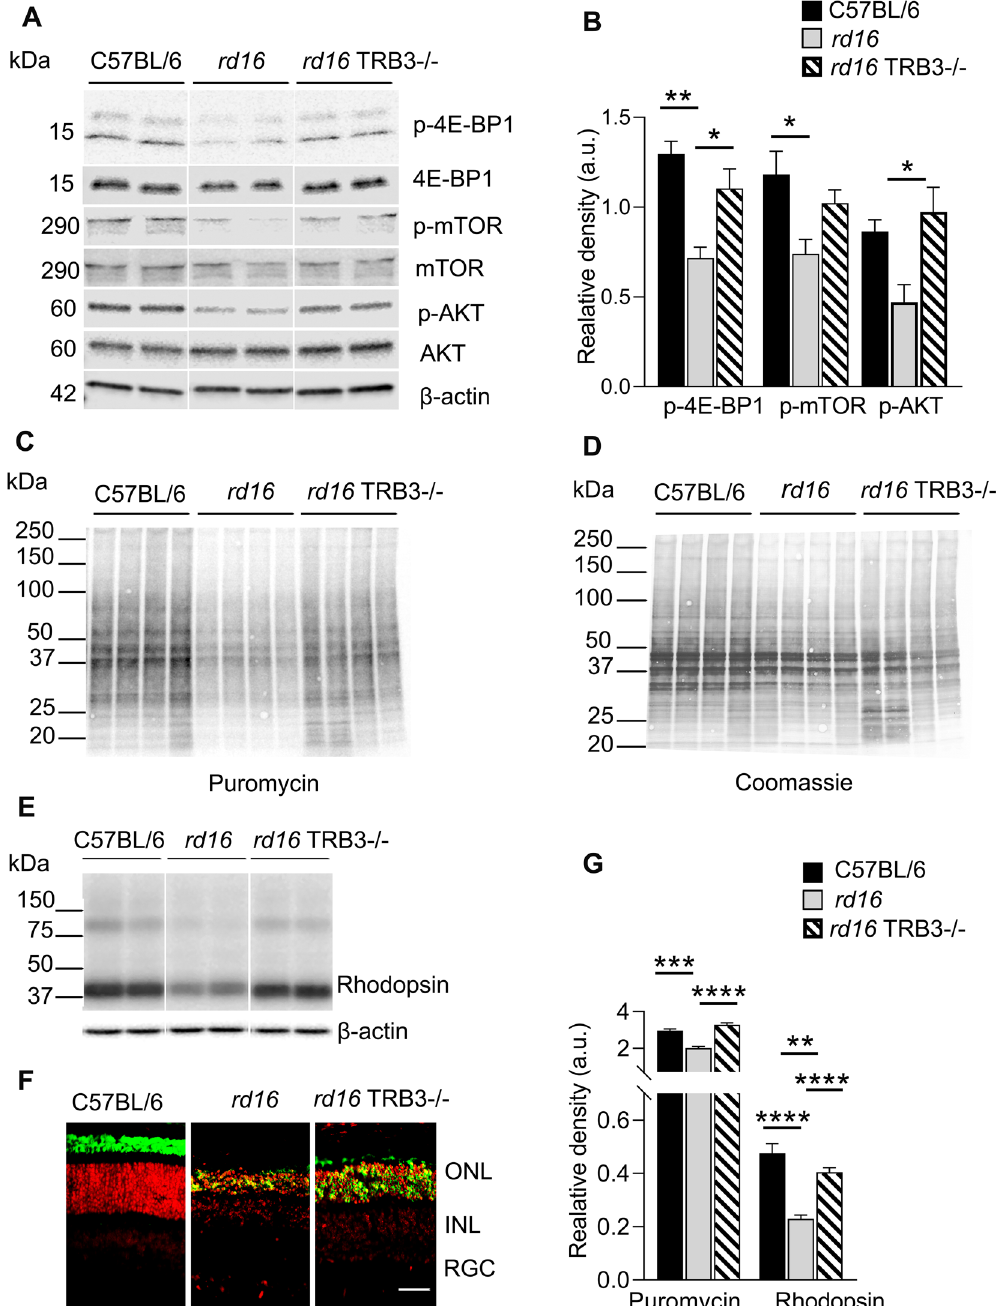
Fig. 1 TRB3 ablation restores the p-AKT/p-mTOR axis in rd16 retinas. A Images of western blot membranes treated with anti-p-4E-BP1, -4E- BP1, -p-mTOR, -mTOR, p-AKT Ser473 , -AKT, and -actin primary antibodies and secondary antibodies scanned with LI-COR imager in three groups of mice. B Quantitation of band density of western blot images demonstrates a statistically signi fi cant increase in p-4E-BP1 and p-AKT in rd16 TRB3 − / − retinas. Increase in p-4E-BP1 was also accompanied by an enhancement of mTOR activity ( n = 4). C Images of a western blot membrane treated with anti-puromycin antibody to detect the translational level in retinas ( n = 4). Retinal protein extracts containing incorporated puromycin as the result of intraperitoneal injection in mice were run to detect the density of incorporated puromycin. The density was normalized through protein loading detected by staining with coomassie blue ( D ). E Retinal protein extracts from P15 C57BL/6, rd16 , rd16 TRB3 − / − mice were run on polyacrylamide gel. Western blot images of membranes immunoblotted with anti-Rhodopsin antibody are shown ( n = 4). F Retinal cryosections of P20 C57BL/6, rd16 , and rd16 TRB3 − / − mice were used to perform the IHC with antibody against rhodopsin (in green). Propidium iodide labels the nuclei of the outer nuclear (ONL) and the inner nuclear (INL) layer, and the retinal ganglion cells (RGC). Accumulation of rhodopsin in the ONL was observed in both rd16 and rd16 TRB3 − / − retinas. G Quantitation of the incorporated puromycin in animal retinas to detect translational level ( C , D ) and rhodopsin protein for western immunoblotting. E The restoration of the translational rate and an increase in rhodopsin level were observed in rd16 TRB3 − / − retinas ( n = 4). Data are shown as mean ± SEM; a.u. = arbitrary units; the scale is 50 µm. * p < 0.05, ** p < 0.01, *** p < 0.001, and **** p < 0.0001.